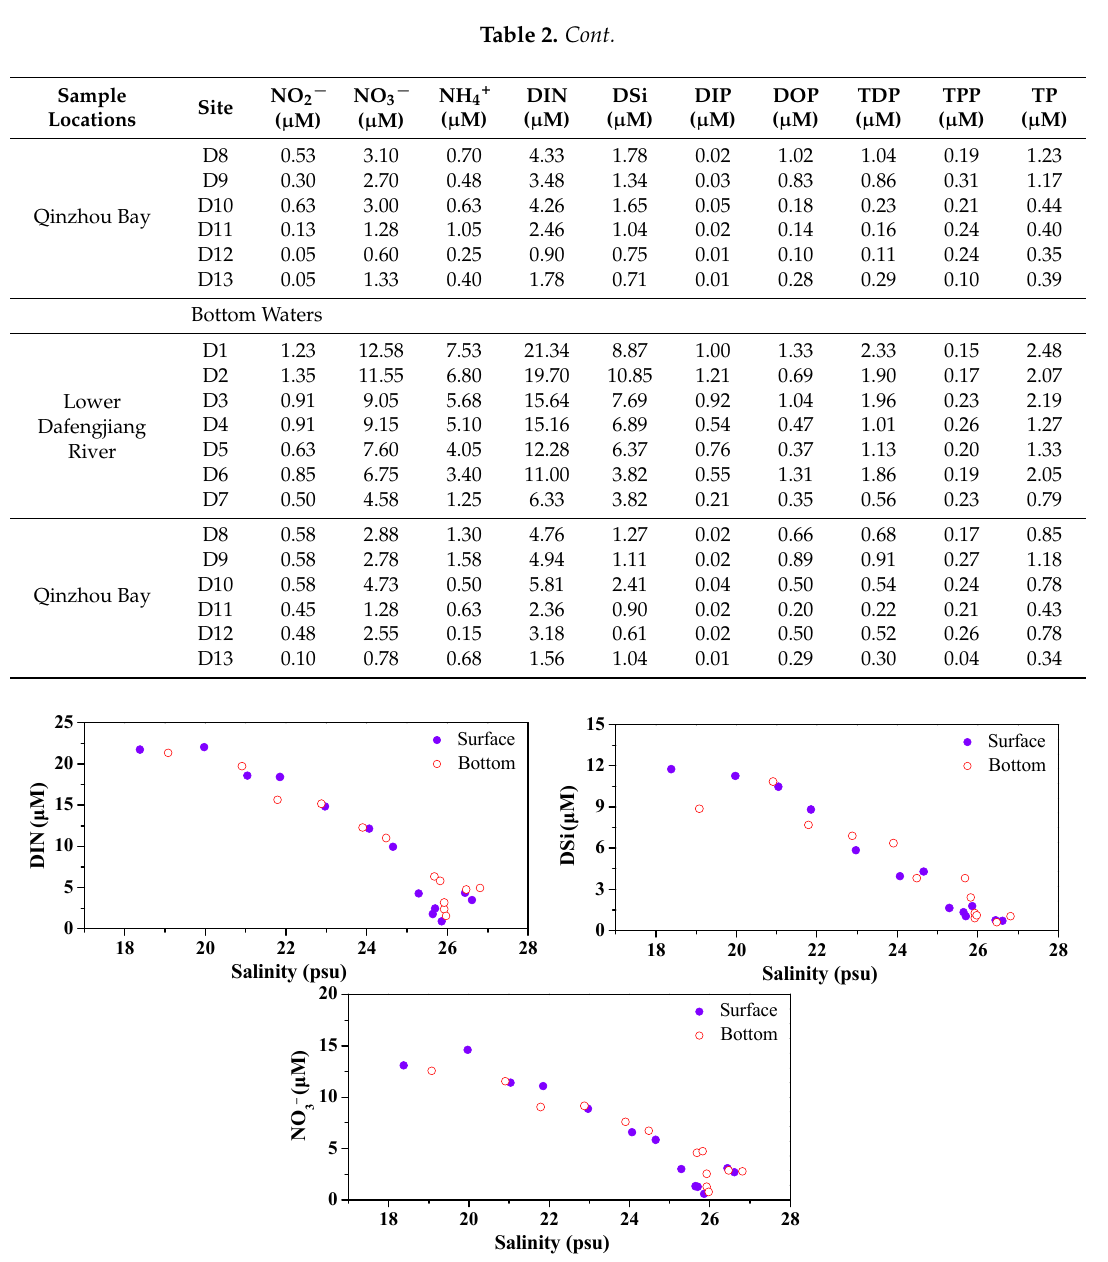
Figure 3. Spatial variations of NO 3− , DIN, and DSi with salinity in surface and bottom waters of the Dafengjiang River estuary. Table 3. The relationship of DIN, DSi, DIP, and TDP vs. salinity both in surface and bottom waters of the Dafengjiang River estuary.